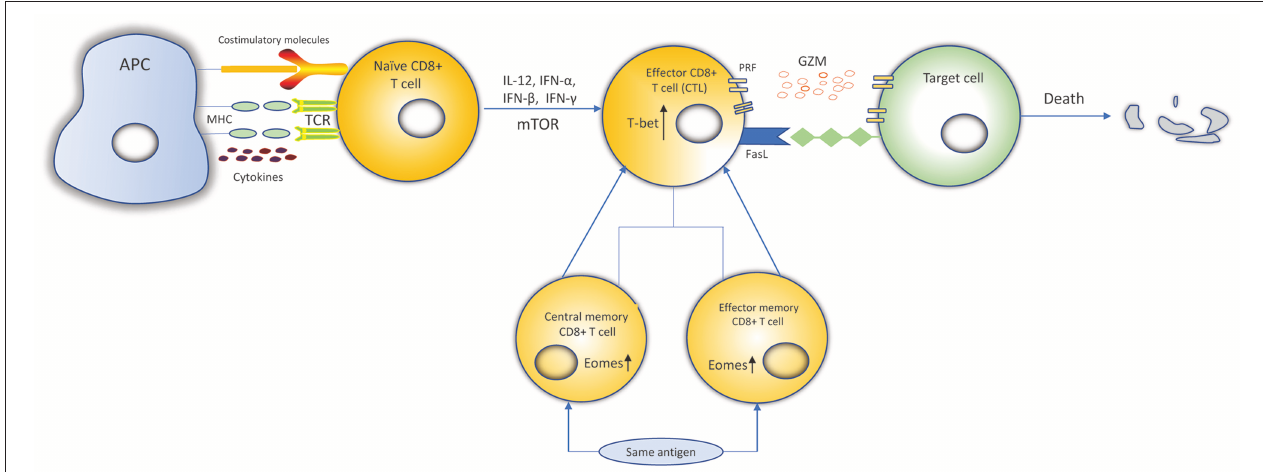
FIGURE 1 | Differentiation and killing mechanisms of CD8 + T cells. Naïve CD8 + T cells expressing the TCRs recognize MHC-I: peptide presented by APCs. Naïve CD8 + T cells are activated. IL-12, IFN- α , IFN- β , IFN- γ , and mTOR can promote the expansion, survival and development of naïve CD8 + T cells to differentiate into CTLs. Transcription factors, such as Eomes, T-bet, increase proliferation of memory CD8 + T cells and cytolytic function of CTLs. CTLs kill target cells by secreting cytolytic granules (PRF and GZM) or recognizing the Fas receptors expressed on the target cell surface to induce the death of target cell. Most of the CTLs experience apoptosis and the remaining CTLs differentiate into central memory and effector memory CD8 + T cells. When re-encountering the same antigens, they can be activated and differentiate into CTLs to kill target